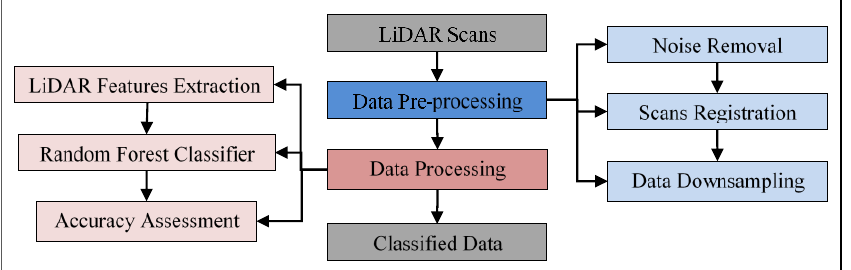
Figure 2. LiDAR point cloud classification workflow. The workflow input (3D point cloud) and output (classified point cloud) are in gray color, the data pre-processing stage is in blue color and the data processing stage is in magenta color.